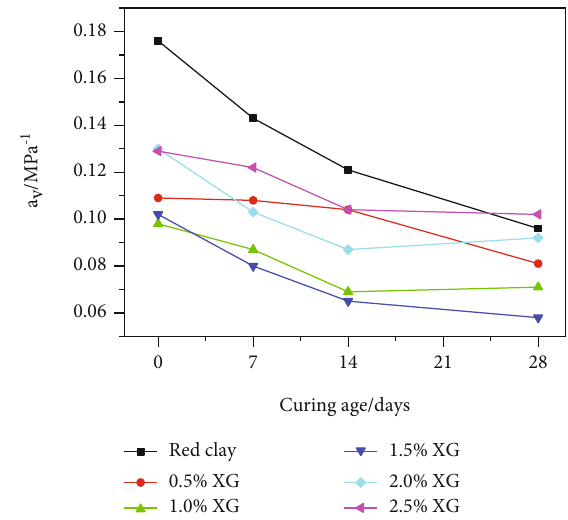
Figure 7: Relationship of curing ages and compression modulus.